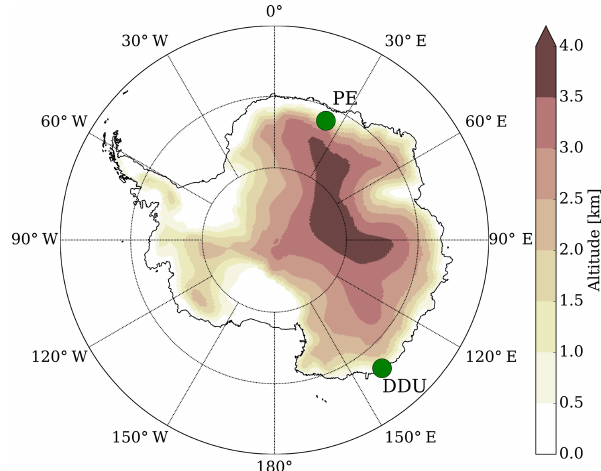
Figure 1. Topography (Bamber et al., 2009) of the Antarctic con- tinent. Green points represent the location of the Dumont d’Urville (DDU) and Princess Elisabeth (PE)